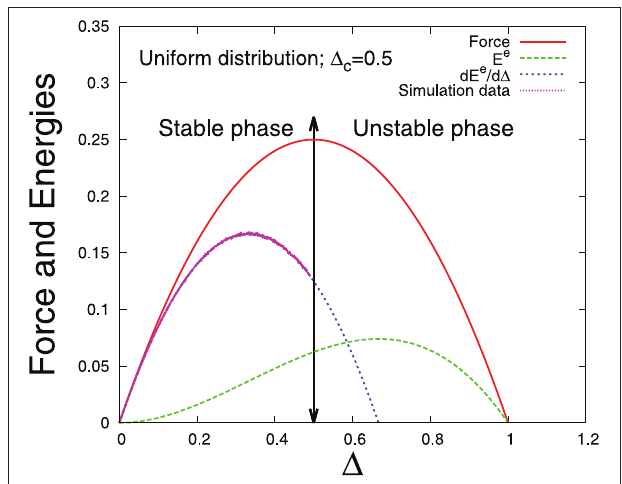
FIGURE 7 | Force and elastic energies vs. extension 1 for fiber bundles with uniform distribution of thresholds: Comparison with simulation data for a single bundle with N 10 7 fibers. =